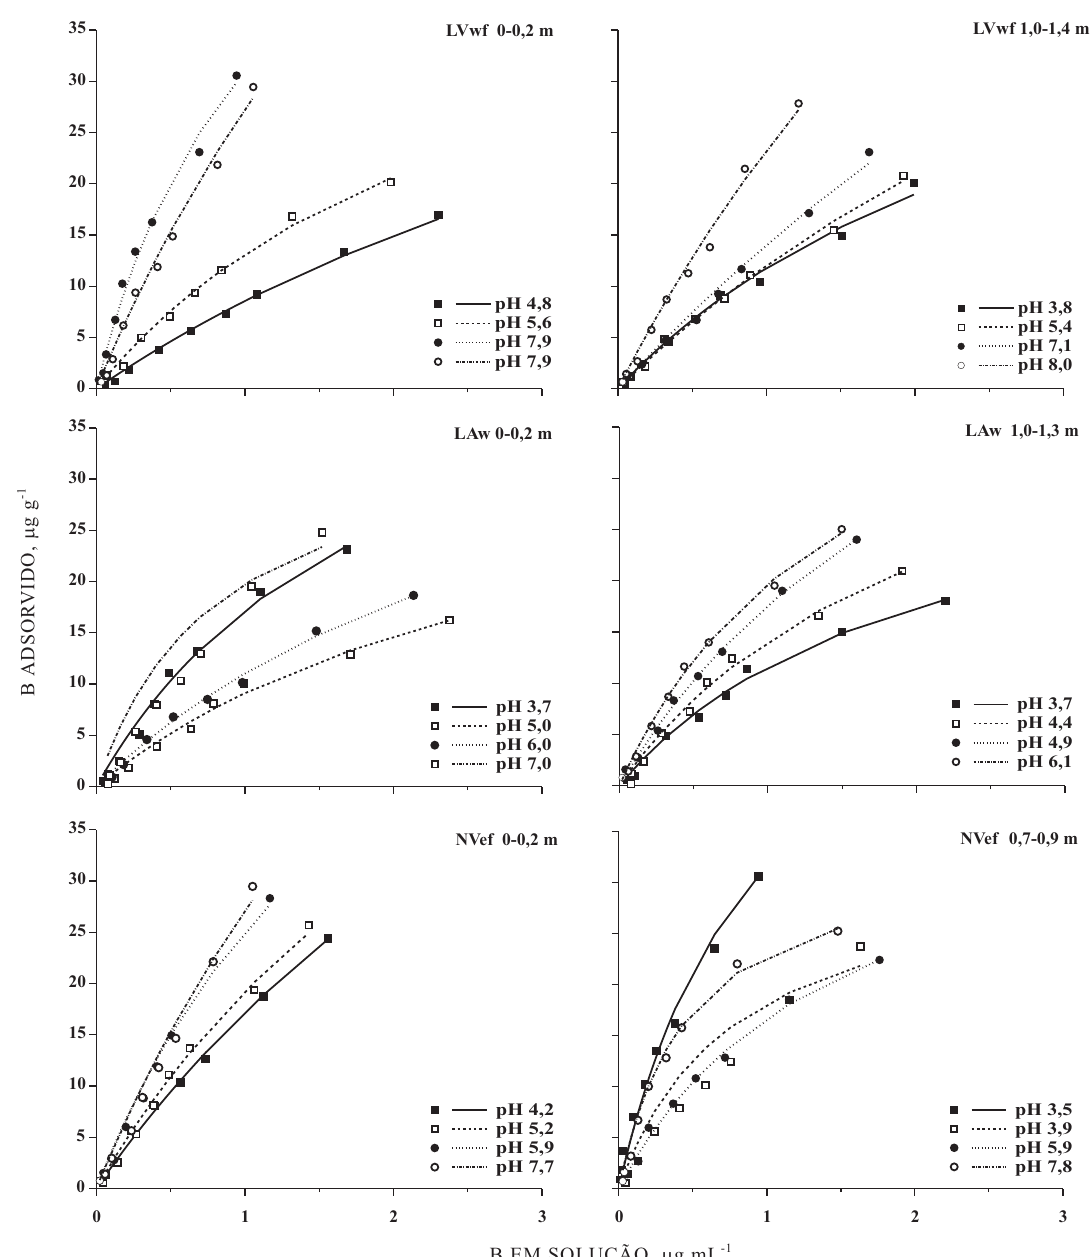
Figura 1. Isotermas de adsorção (curvas) obtidas a partir do ajuste da equação de Langmuir aos resultados experimentais (pontos). (LVwf = Latossolo Vermelho Acriférrico; LAw = Latossolo Amarelo Ácrico; NVef = Nitossolo Vermelho